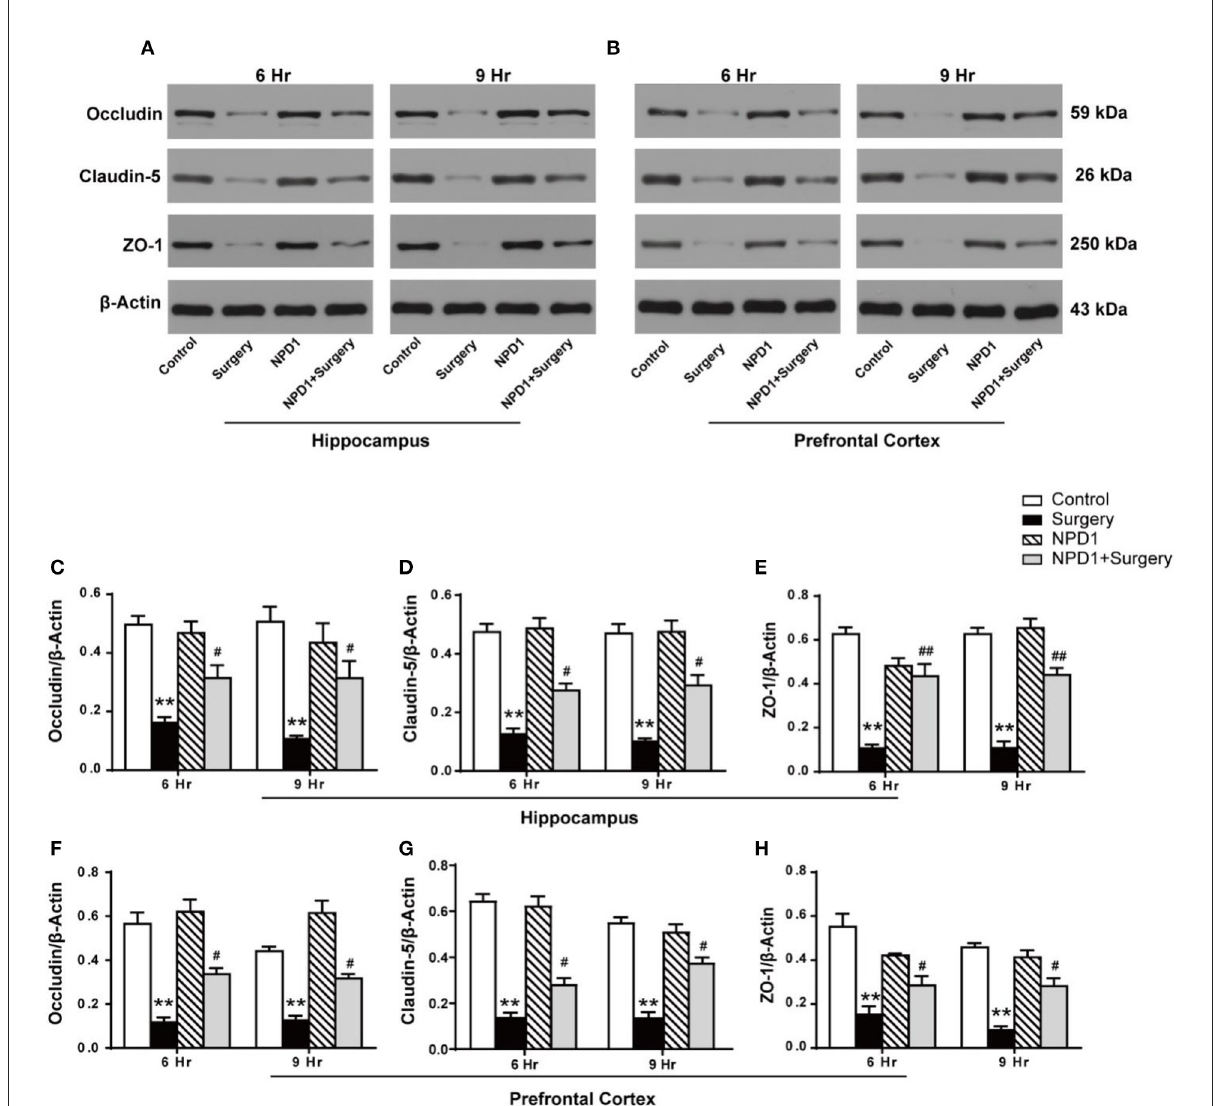
FIGURE4 NPD1 modulates the expression of tight junction (TJ)-associated proteins in the hippocampus and prefrontal cortex after surgery. Representative Western blotting bands of the expression of occludin, claudin-5, and ZO-1 in the hippocampus and prefrontal cortex at 6 and 9h after surgery (A,B) . Quantification analyses of the expression of occludin, claudin-5, and ZO-1 were normalized to that of β -actin as internal control (C–H) . Data are presented as mean ± SEM. Statistics: two-way ANOVA followed by Bonferroni post hoc comparison. (C–H) n = 4–5 per group. ** P < 0.01 vs. the control group, # P < 0.05 vs. the surgery group, ## P < 0.01 vs. the surgery